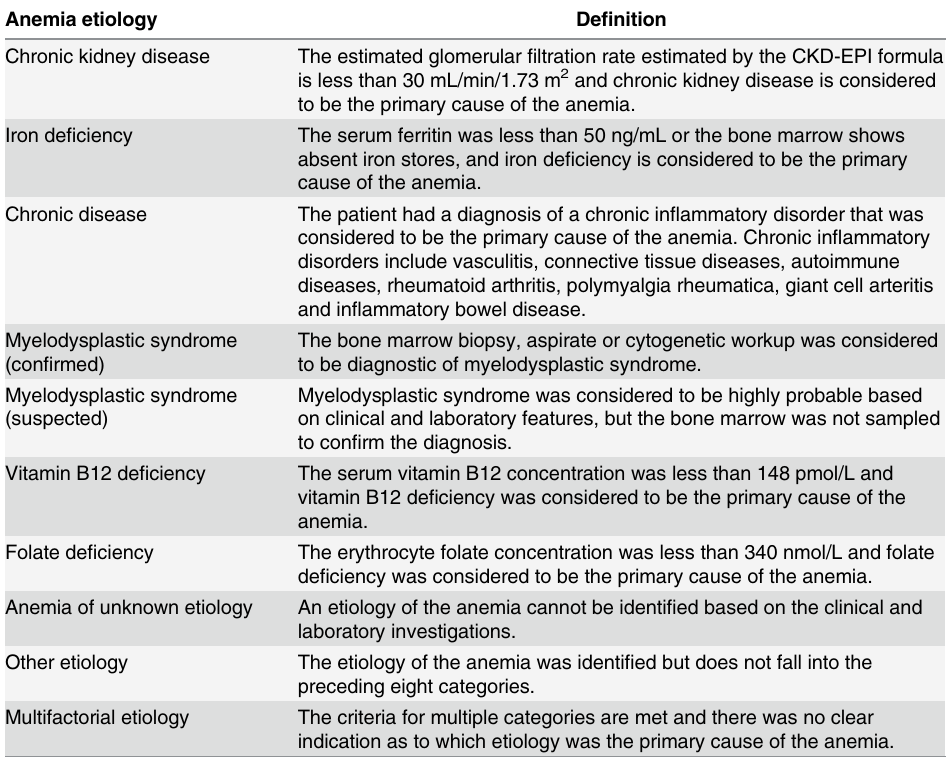
Table 1. Criteria used to assign an etiology to a patient ’ s